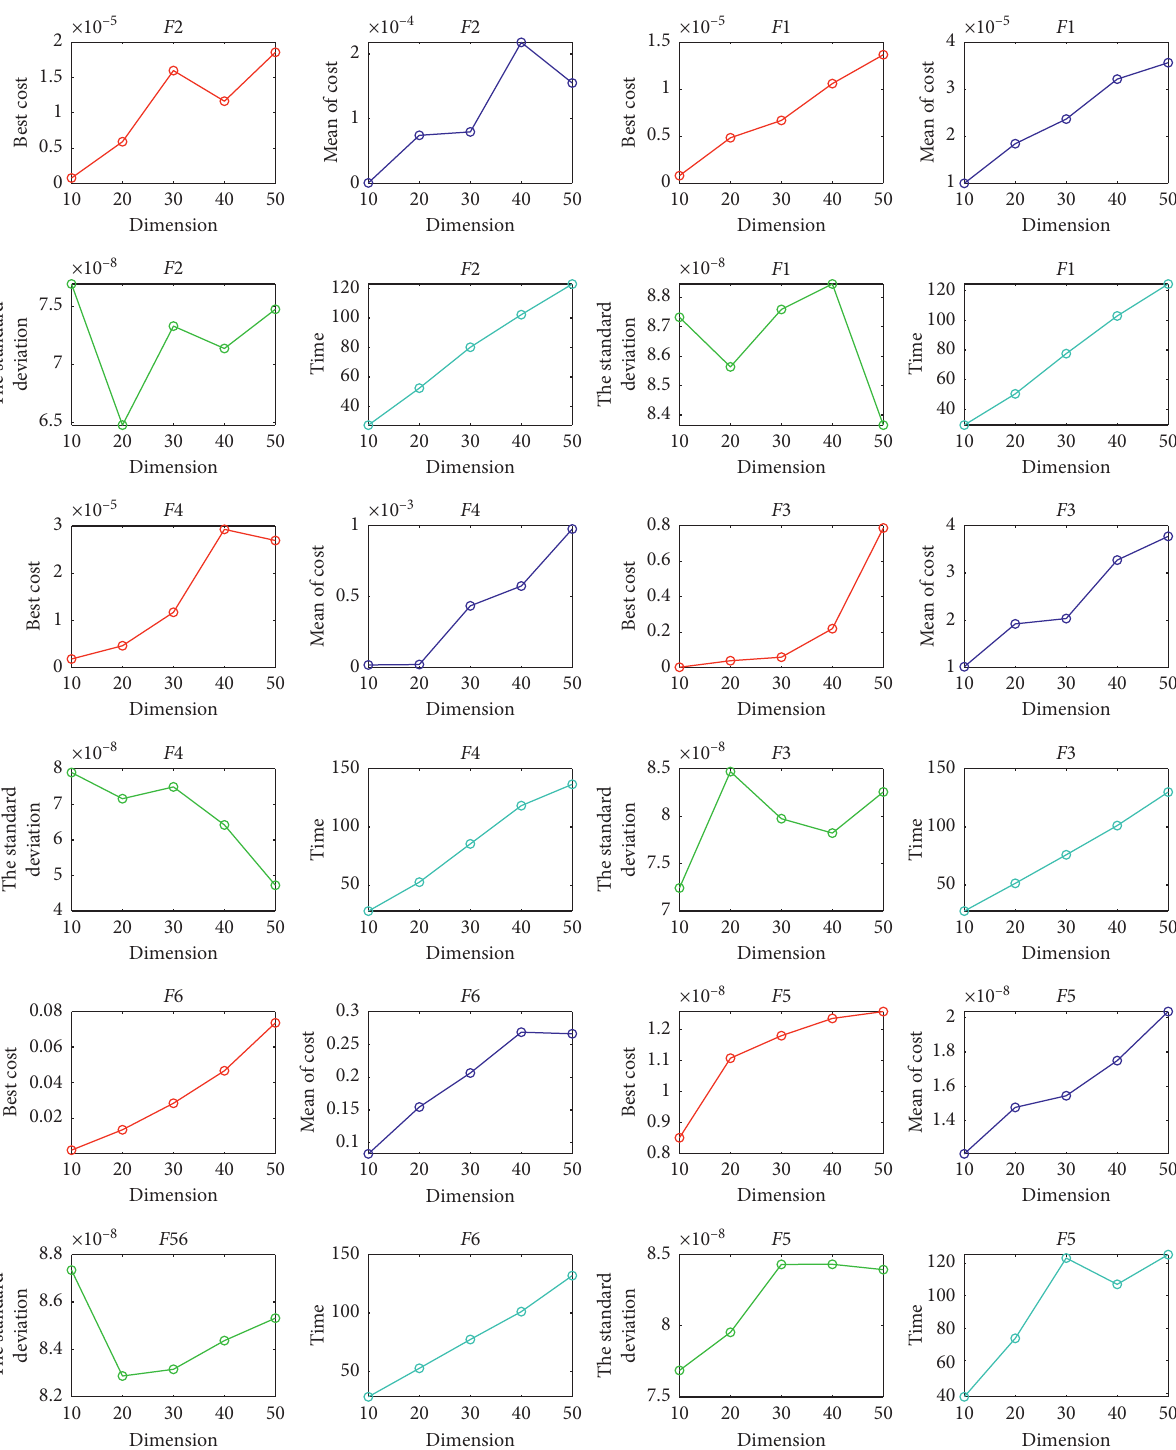
Figure 3, the valid work regions for cogeneration power-heat unit numbers 1 and 2 are depicted.